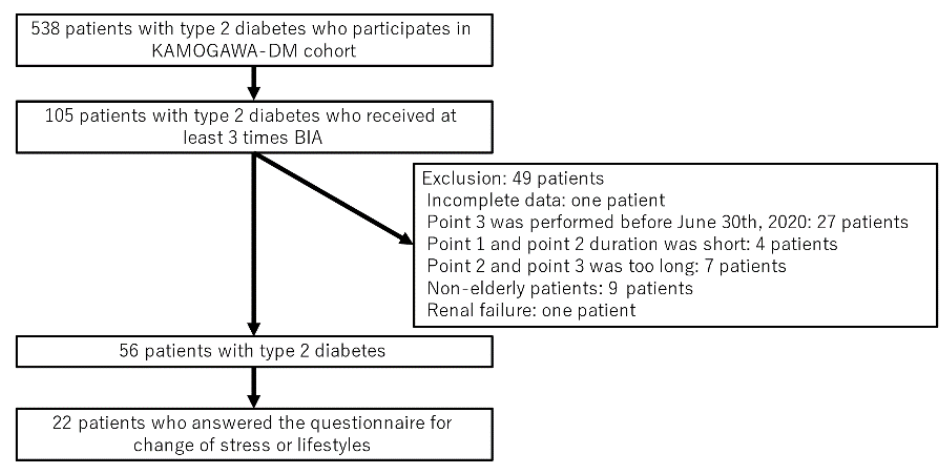
Figure 2. Inclusion and exclusion flow.